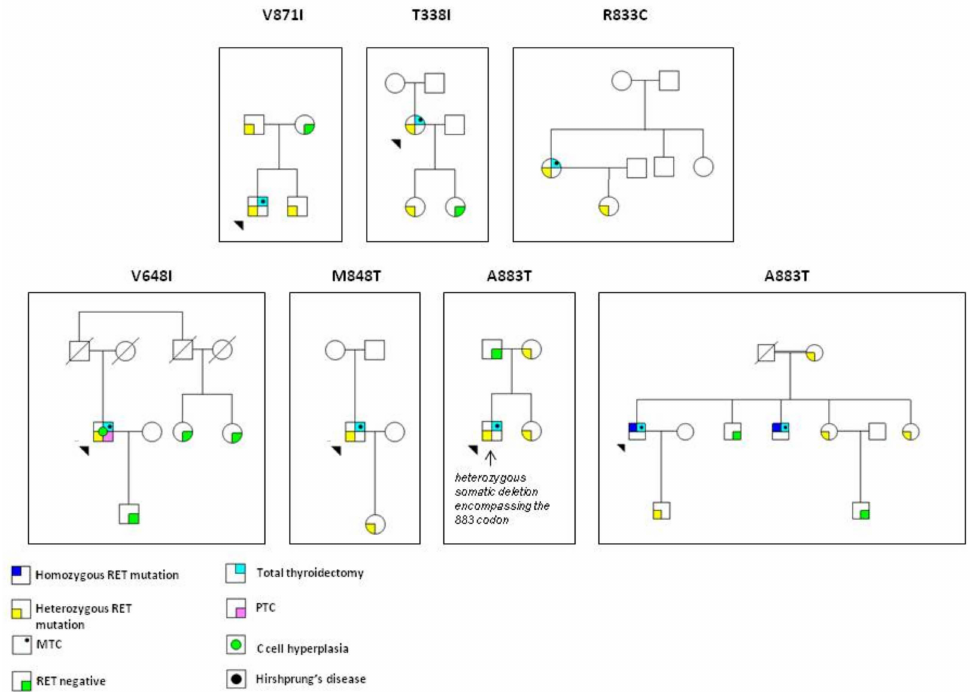
Figure 3. Pedigrees of MEN2 families with germline RET mutation classified as VUS. With the exception of a A883T RET mutated family in which medullary thyroid carcinoma (MTC) was present in two homozygous patients, MTC was present only in one member of the family. PTC: Papillary Thyroid